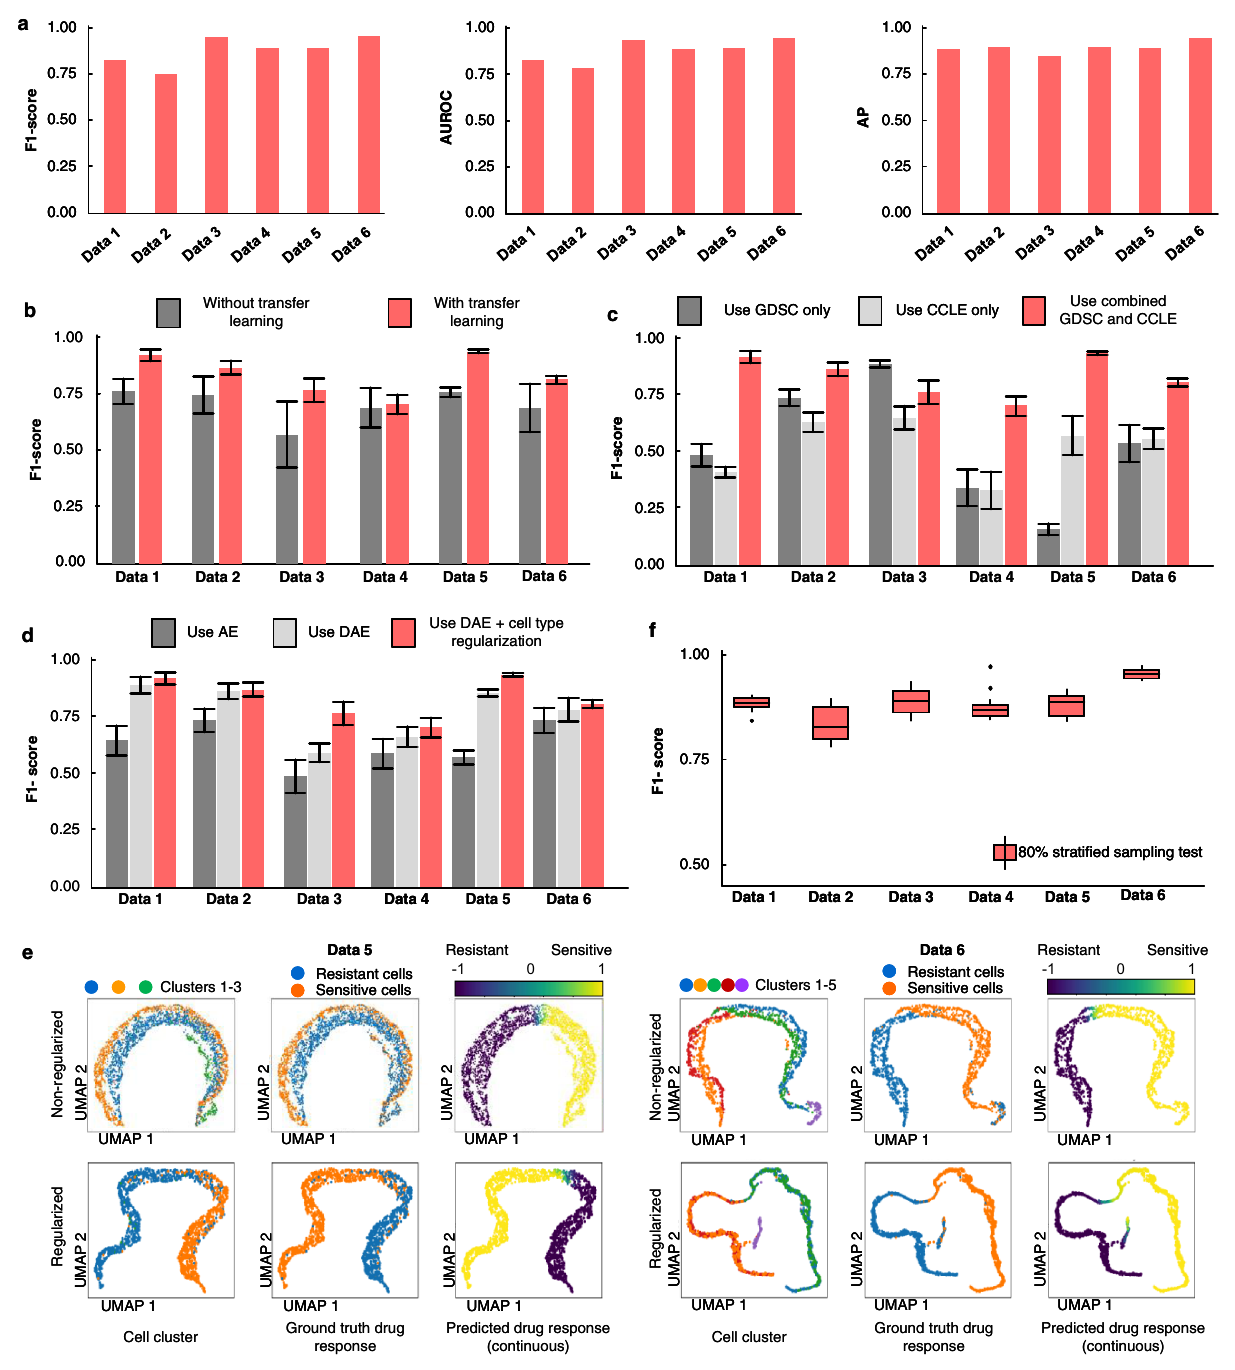
Fig.2|BenchmarkingresultsofscDEAL.a Optimizedbenchmarkingresultsofall six datasets using scDEAL. Source data are provided as Source Data 1: optimized benchmarking results of seven metrics. b F1-score comparison using GDSC data- base only, CCLE database only, and both databases in training scDEAL for all six datasets. The bar plot shows the mean F1-scores of each data ( n =50; same para- meter settings for each data; different seeds), with error bars representing +/ − standard deviations. The same rules are also applied for the bar plots in c and d. Source data are provided as Source Data 2: F1-score of 50 repeated experiments comparing with and without transfer learning in six datasets. c Drug response prediction comparisons of scDEAL framework using common autoencoder (dark grey), denoising autoencoder (light grey), and the combination of denoising autoencoder in feature extraction and cell-type regularization in DaNN loss func- tionfortransferlearning(pink).SourcedataareprovidedasSourceData3:F1-score